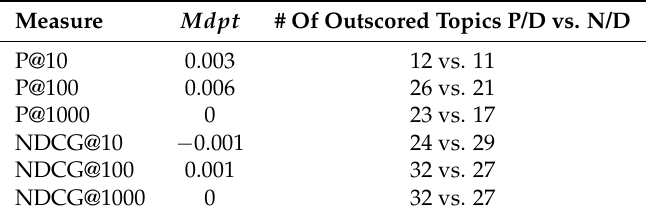
Table 15. T1: mdpt of P/D vs. N/D and count of the number of topics in which P/D is better than N/D and